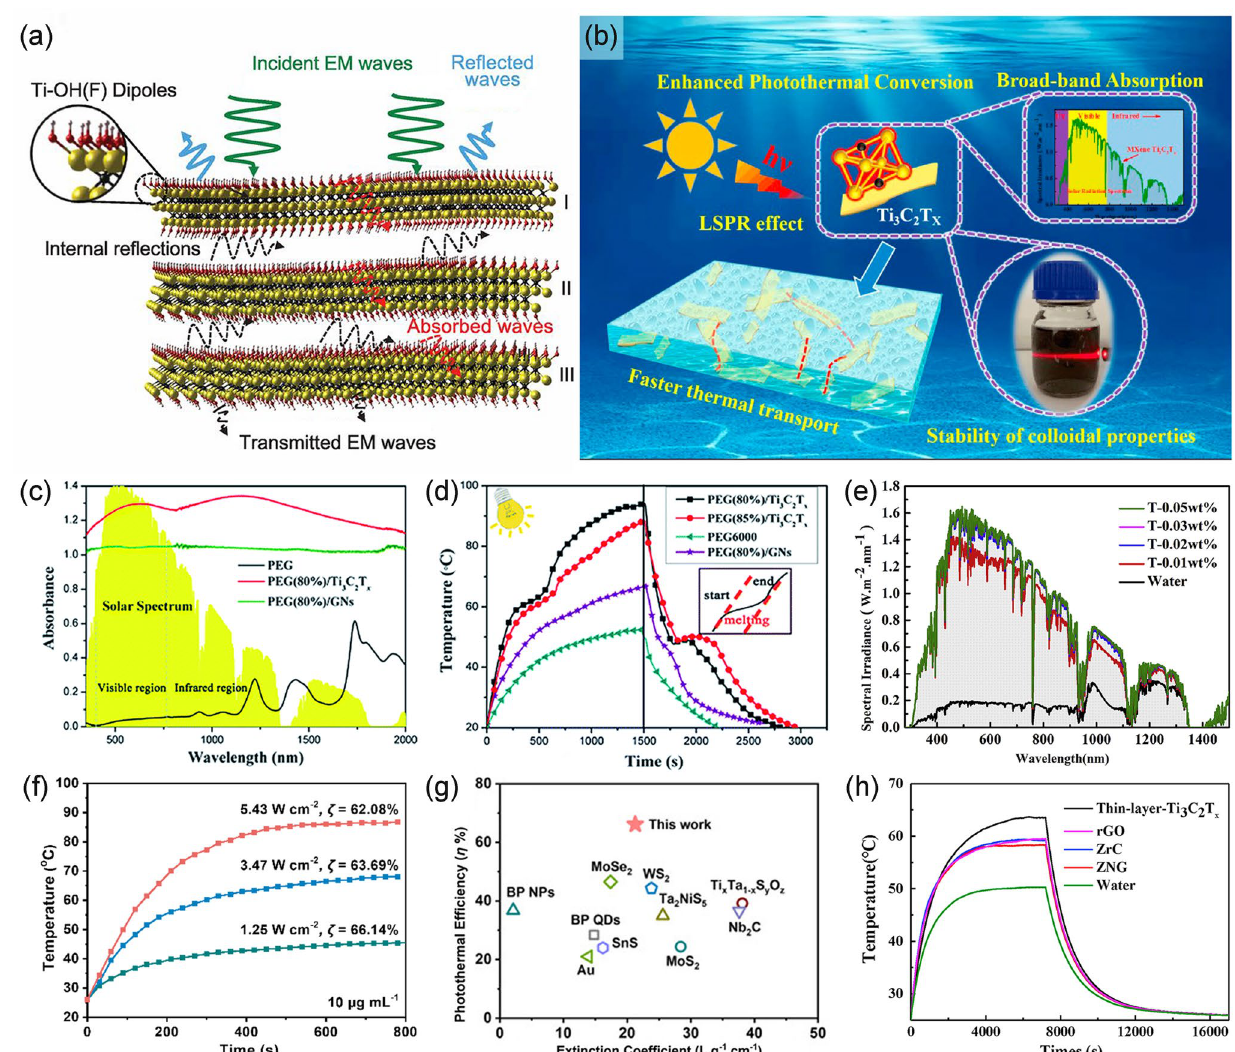
Fig. 6 a Schematic illustration of electromagnetic wave penetration/reflection/absorption [86]. Copyright 2016, The American Association for the Advancement of Science. b Schematic illustration of the radiation energy conversion mechanism of Ti 3 C 2 T x [106]. Copyright 2020, Else- vier. c Absorbance spectra of polyethylene glycol (PEG)/Ti 3 C 2 T x composite; d Temperature evolution curves of the PEG/Ti 3 C 2 T x composites under the simulated sunlight irradiation [111]. Copyright 2019, Royal Society of Chemistry. e The spectral irradiance of Ti 3 C 2 T x with